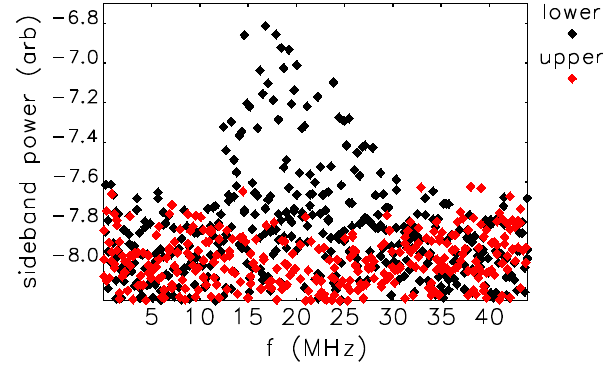
FIG. 6. Simulated ion density (averaged around the ring) for 324 bunches, 200 mA, 1000 Ah conditioning.